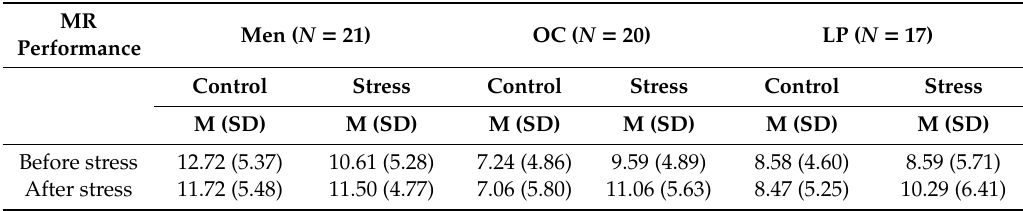
Table 2. Means (SD) for group di ff erences in mental rotation performance before and after exposure to either the stress procedure or a nonstress control